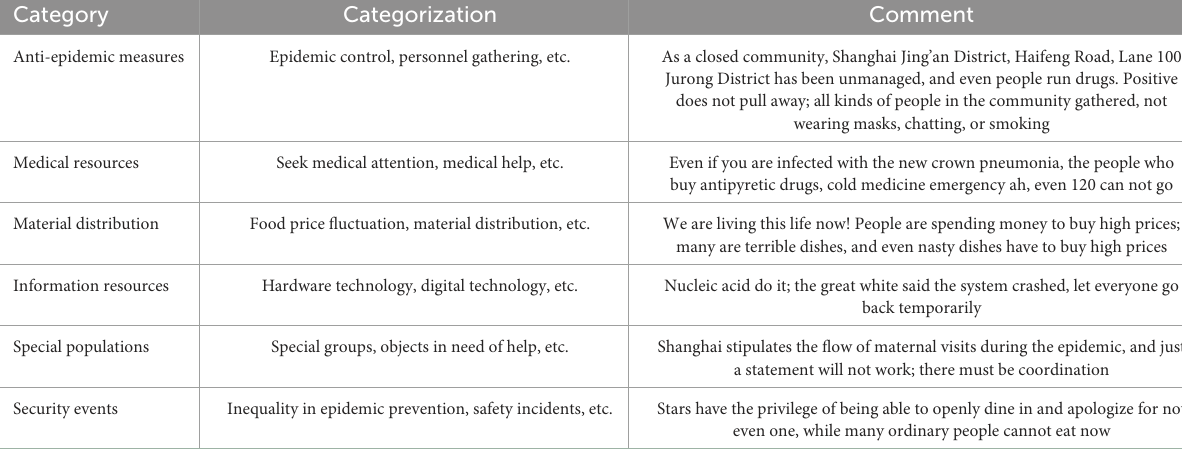
Medical resources